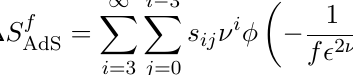
for any D = 5. Notice it is increases 2